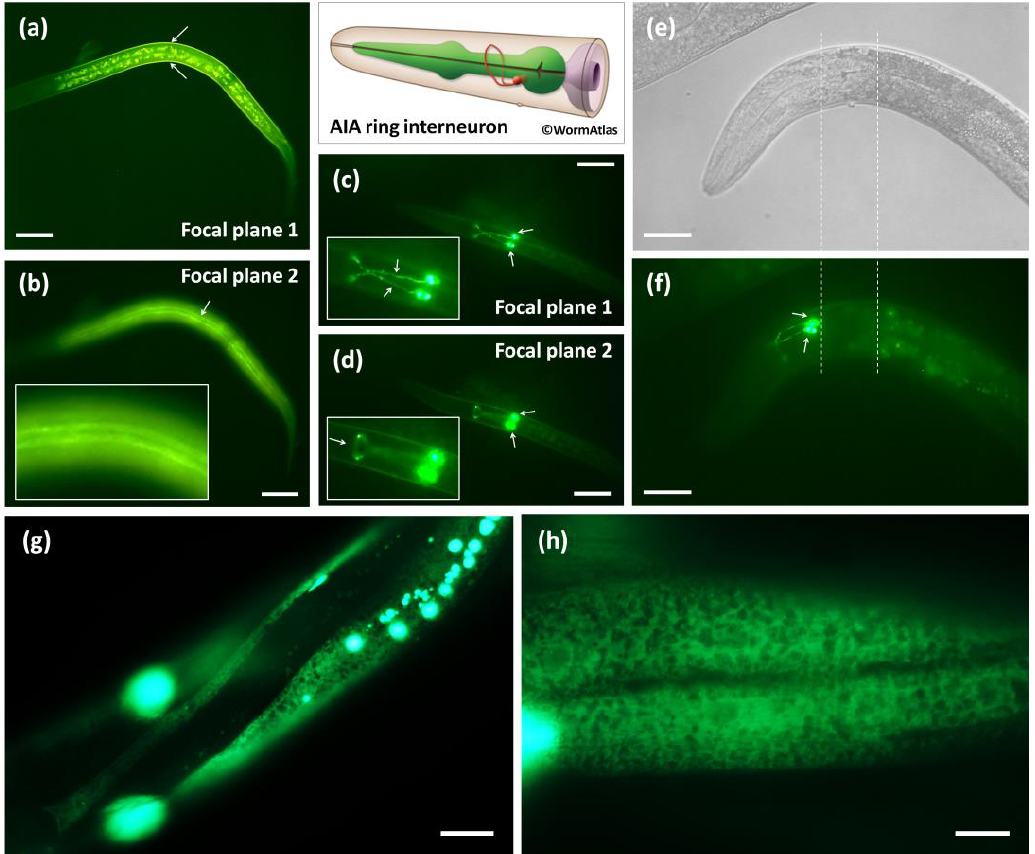
Figure 2. In vivo expression of calu-1 in dauers and adults. ( a , b ), transgenic animals expressing the promoter of calu-1 fused with GFP (transcriptional reporter); ( c – h ), transgenic animals expressing the full-length cDNA of calu-1 fused with GFP, driven by its own promoter (translational reporter). ( a ) It is visible that body-wall muscles surround the body of dauer larvae (indicated by arrows). ( b ) One of four quadrants of the body-wall muscles is visible (indicated by an arrow and a magnified image) ( c , d ) Cell bodies (AIAL and AIAR, indicated by arrows) and dendrites of the AIA interneuron are clearly visible. The dendrites are more visible in (( c ); indicated by arrows in a magnified image) and the nerve ring of the dendrites is only visible in (( d ); indicated by an arrow in a magnified image). Normaski ( e ) and GFP ( f ) images of a young adult. The terminal bulb of the pharynx is indicated by two dashed lines ( e , f ). ( f ) AIA interneuron is clearly visible, with cell bodies (indicated by arrows) and dendrites. calu-1 is found in the ER of the hypodermis ( g ) and the muscle ( h ) of adults. Scale bars, 20 μm, 10 μm only in ( h ).